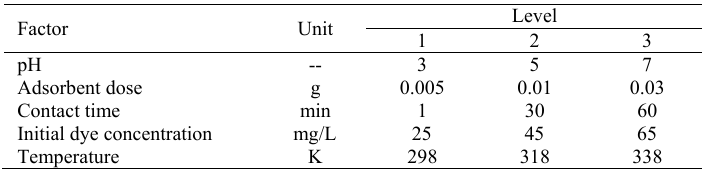
Table 1. Factors and their levels for design of